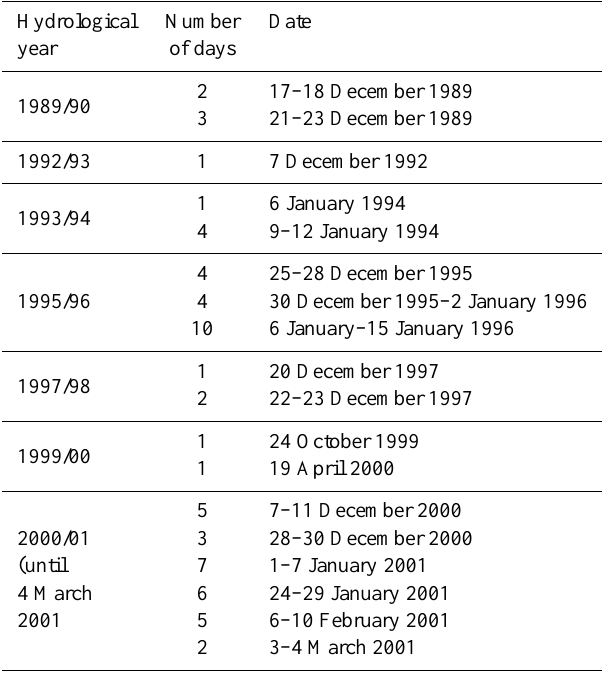
Table 2. Number of days with daily average flow discharged by the Carrapatelo dam ≥ 3000m 3 s − 1 .